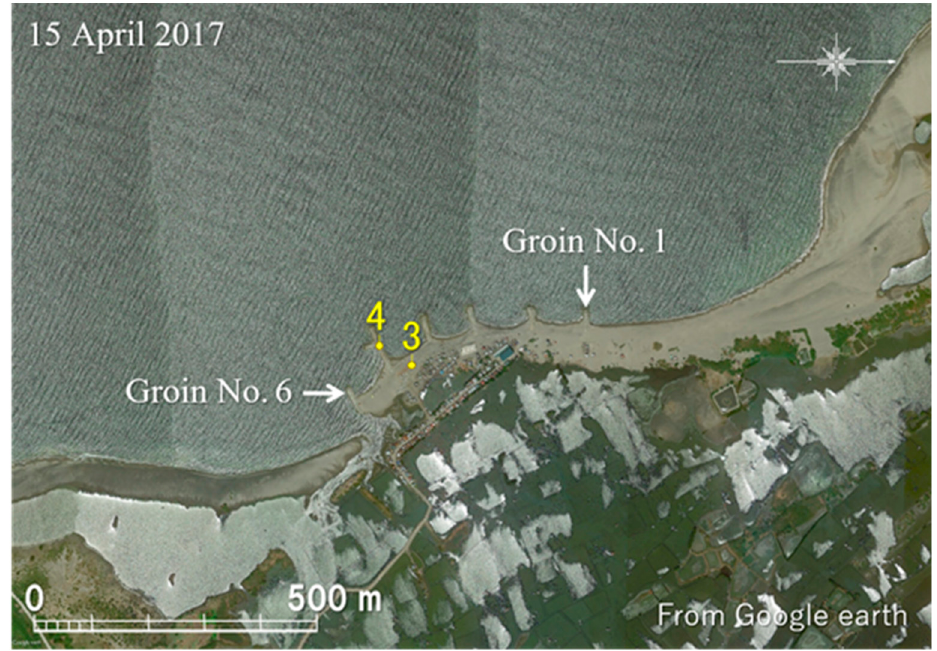
Figure 18. Enlarged satellite image of the shoreline in the rectangular area in Figure 17. In this area, six groins were installed to protect the village, whereas the shoreline markedly retreated south of groin No. 6. For example, the village houses between groins Nos. 4 and 5, made of large boulders with a crown height of 2 m above mean sea level, were protected by a sandy beach between groins, as shown in Figure 19. Similarly, the intertidal beach was left north of groin No. 6.